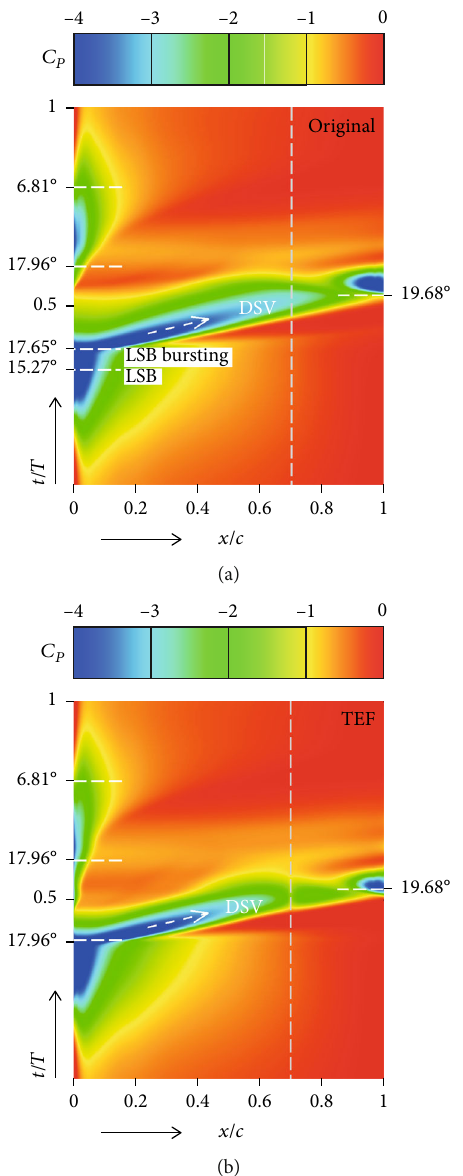
Figure 13: Spatiotemporal contours of pressure coe ffi cients on the airfoil upper surfaces: (a) original airfoil and (b) TEF